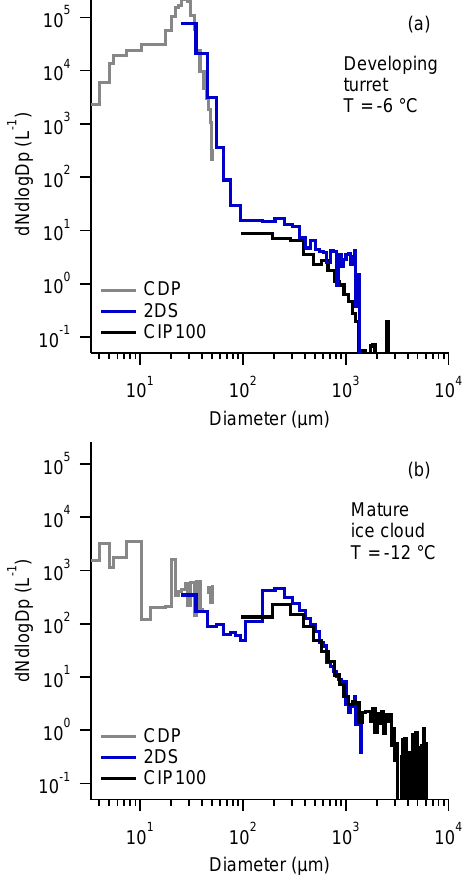
Figure 1. Comparison of size distributions from the CDP, 2DS, and CIP100 probes during selected cloud penetrations through (a) a de- veloping turret and (b) a mature glaciated region. The first two size bins from the 2DS and CIP100 were removed, as they are subject to larger uncertainty, and are not used in this